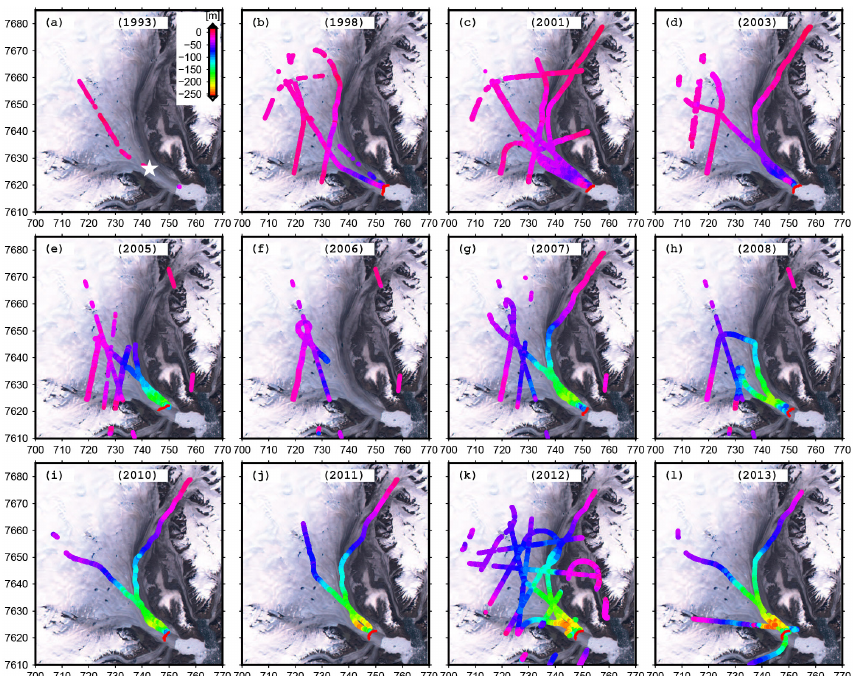
Figure 5. Elevation changes relative to 1981 on Kangerdlugssuaq Glacier. Same as for Fig. 4, but for Kangerdlugssuaq Glacier. The panels show elevation changes of Kangerdlugssuaq Glacier during (a) 1981–1993, (b) 1981–1998, (c) 1981–2001, (d) 1981–2003, (e) 1981–2005, (f) 1981–2006, (g) 1981–2007, (h) 1981–2008, (i) 1981–2010, (j) 1981–2011, (k) 1981–2012, (l) 1981–2013. The white star in (a) represents the location of the time series shown in Fig. 7b. The background map is a Landsat7 ETM + “true color” image from 6 August 1999. The axes displays UTM zone 24 coordinates in kilometres.